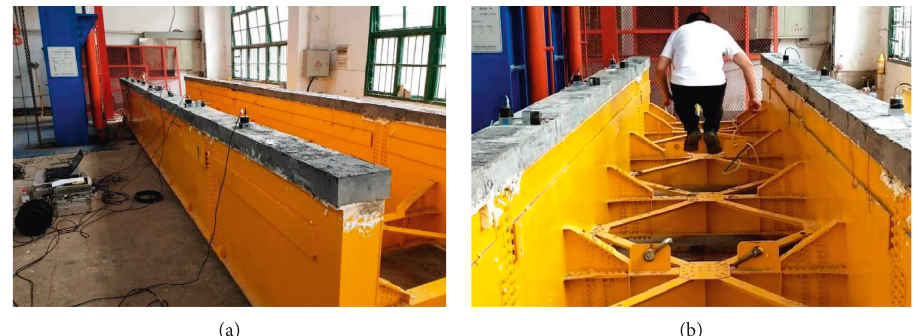
Figure 7: Dynamic test scheme. (a) Layout of vibration pickups. (b) Excitation scheme of